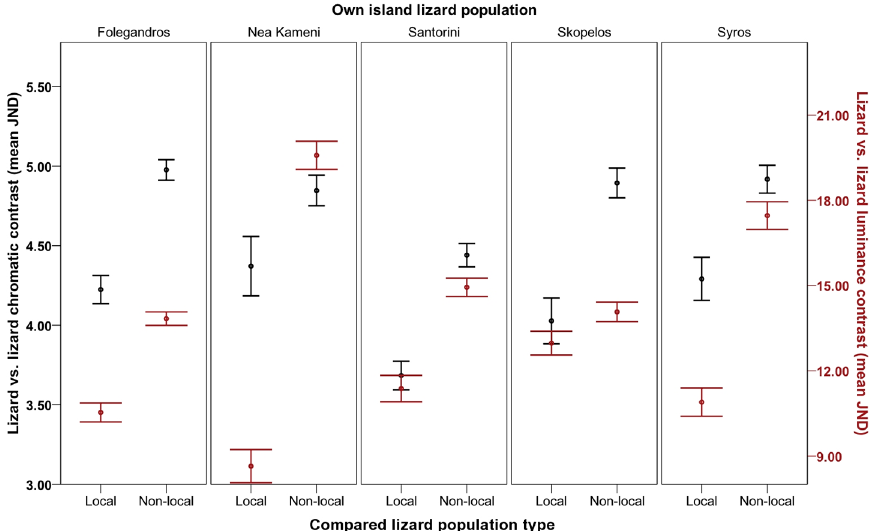
Fig 2. Degree of lizard contrast between island populations. Degree of contrast refers to how different Aegean wall lizards ( Podarcis erhardii ) are to their local island population relative to how different they are to other (non-local) island populations overall (Folegandros, Nea Kameni, Santorini, Skopelos and Syros) in terms of chromatic contrast (left axis; black data points) and luminance contrast (right axis; red data points) (mean JND). JND values increasing > 3.00 depict populations that are progressively distinguishable by avian predators. Error bars represent +/- 1